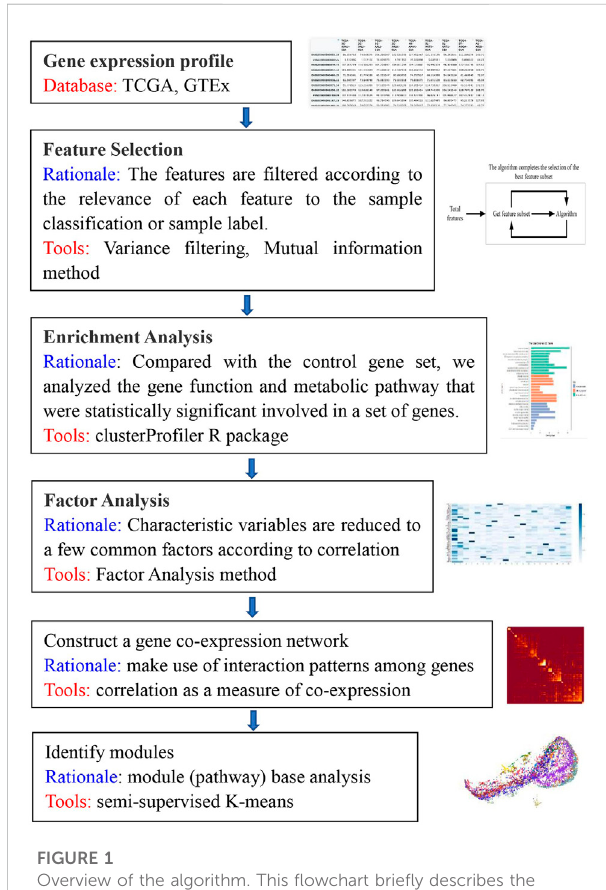
FIGURE 1 Overview of the algorithm. This fl owchart brie fl y describes the main. steps of the KISL